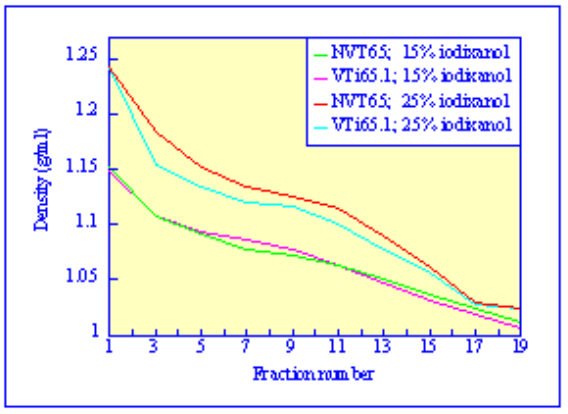
FIGURE 1 . Density profiles: 350,000 g at 4 o C for 3 h.